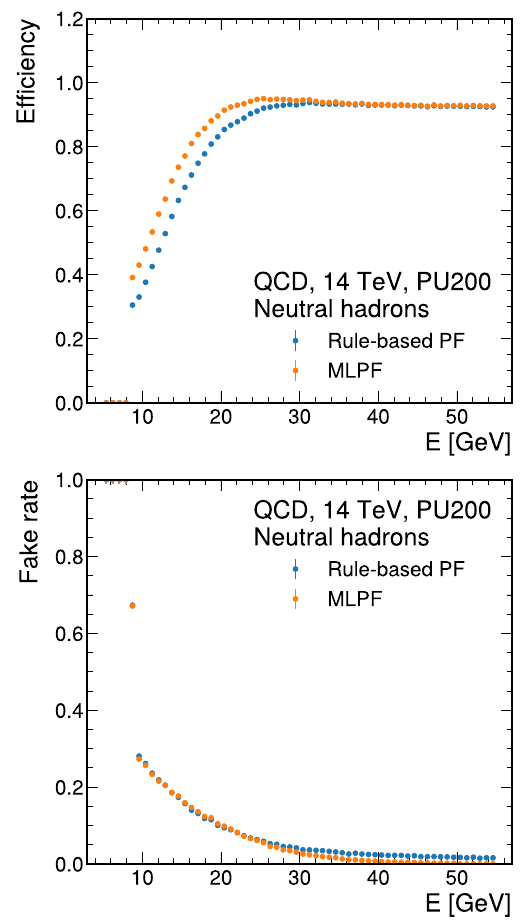
Fig. 8 The efficiency (upper) and fake rate (lower) of reconstructing neutral hadron candidates as a function of the generator particle energy in simulated QCD multijet events with PU. The MLPF model shows comparable performance to the delphes PF benchmark, with a some- what lower fake rate at a similar